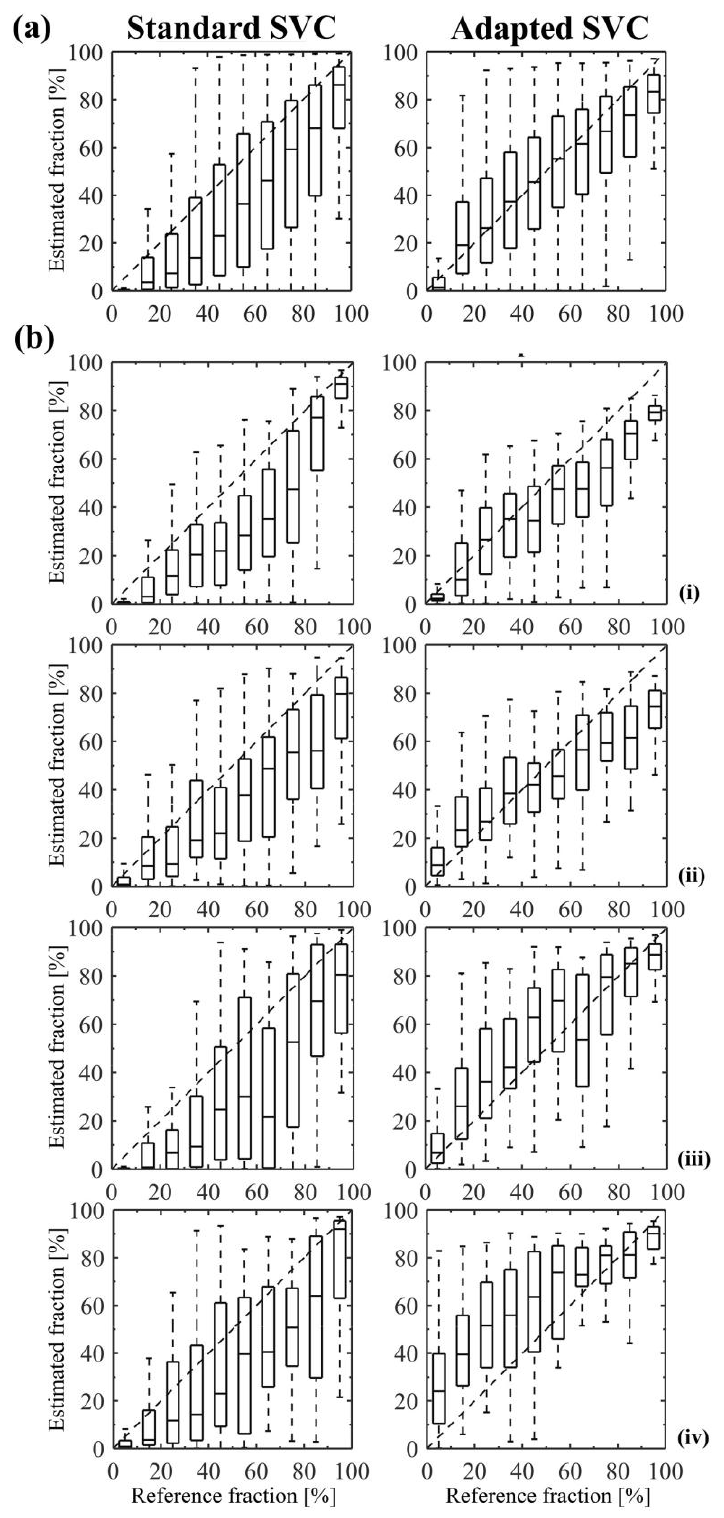
Figure 5. Decil-wise boxplot diagrams of the shrub cover fraction maps derived from standard SVC (left) and adapted SVC (right) ( a ) for the entire study area and ( b ) for selected subsets. For each box of the boxplots, the central mark is the median, the edges of the box are the 25th and 75th percentiles, and the whiskers extend to the outliers [61]. Perfect prediction is highlighted with a dashed 1:1